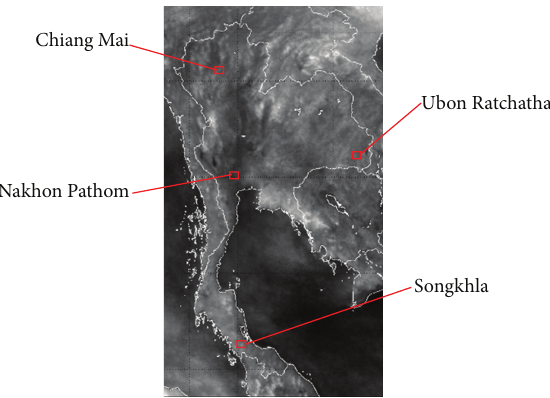
Figure 1: A rectified image and the positions of the target ground-based